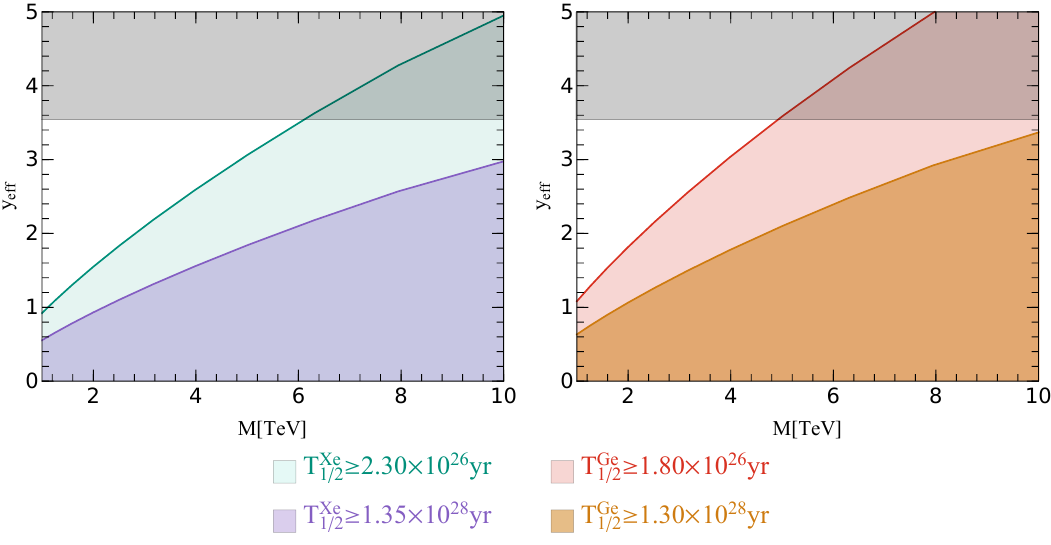
Figure 19 . The constraint on the effective coupling y decay of 136 Xe and 76 Ge, where the highlighted regions are allowed by the 0 νββ decay search. The horizontal grey band is excluded by the perturbative constraint y